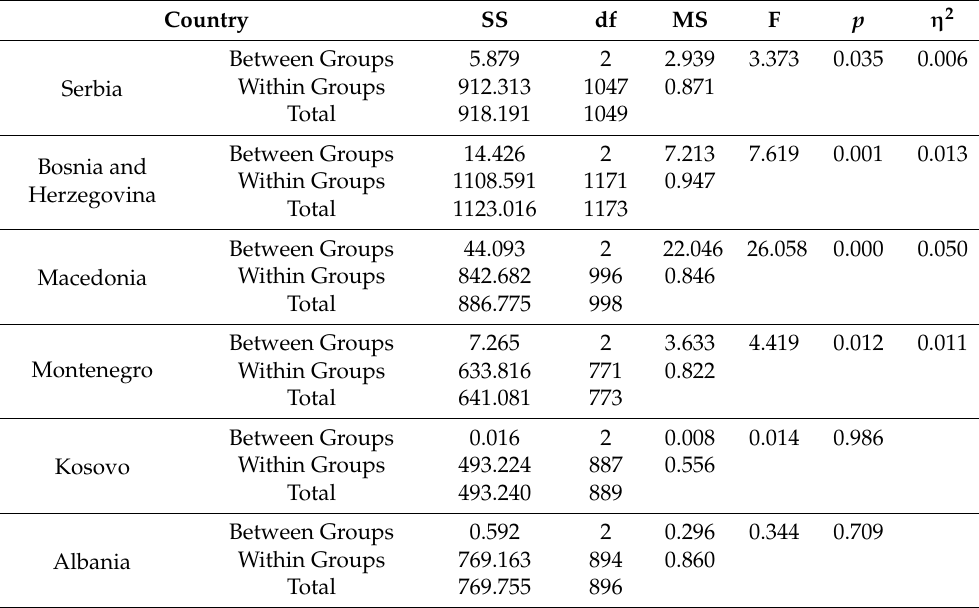
Table A18. Accepting/giving a bribe by confession among